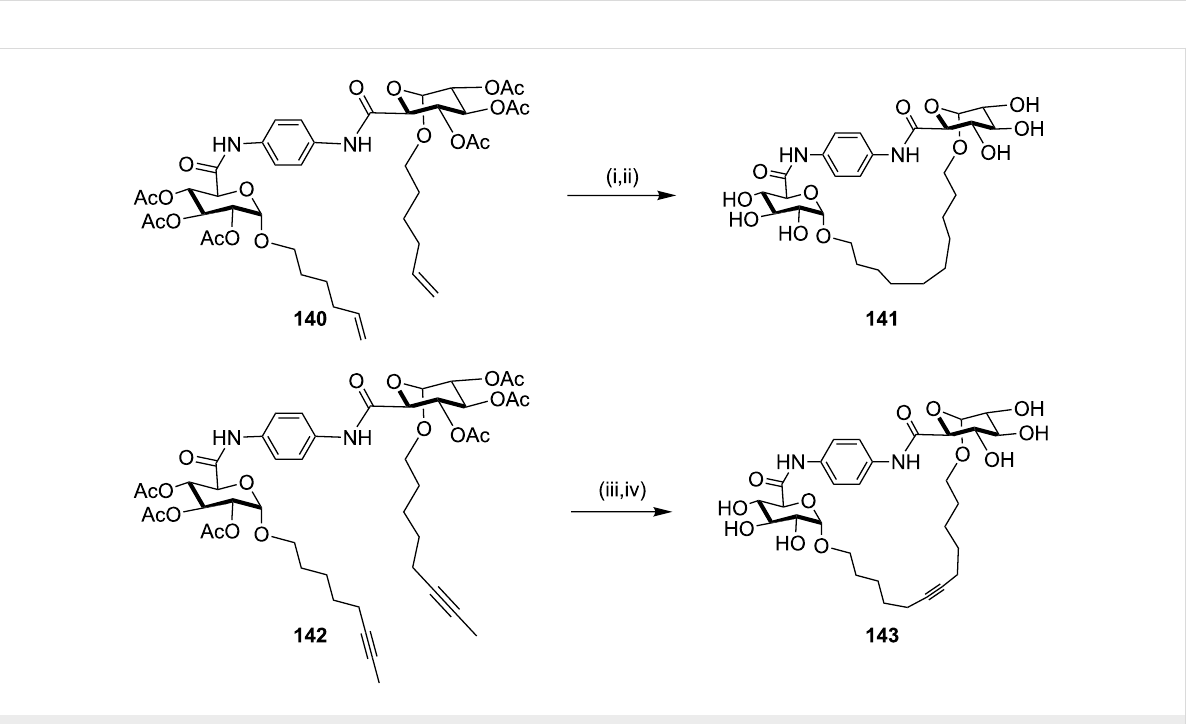
Scheme 20: Synthesis of cyclophanes via Wurtz coupling reaction Reagents and conditions: (i) PhLi, Et 2 O, C 6 H 6 , reflux, 39%; (ii) Na, NaI (cat), PhBr (cat),